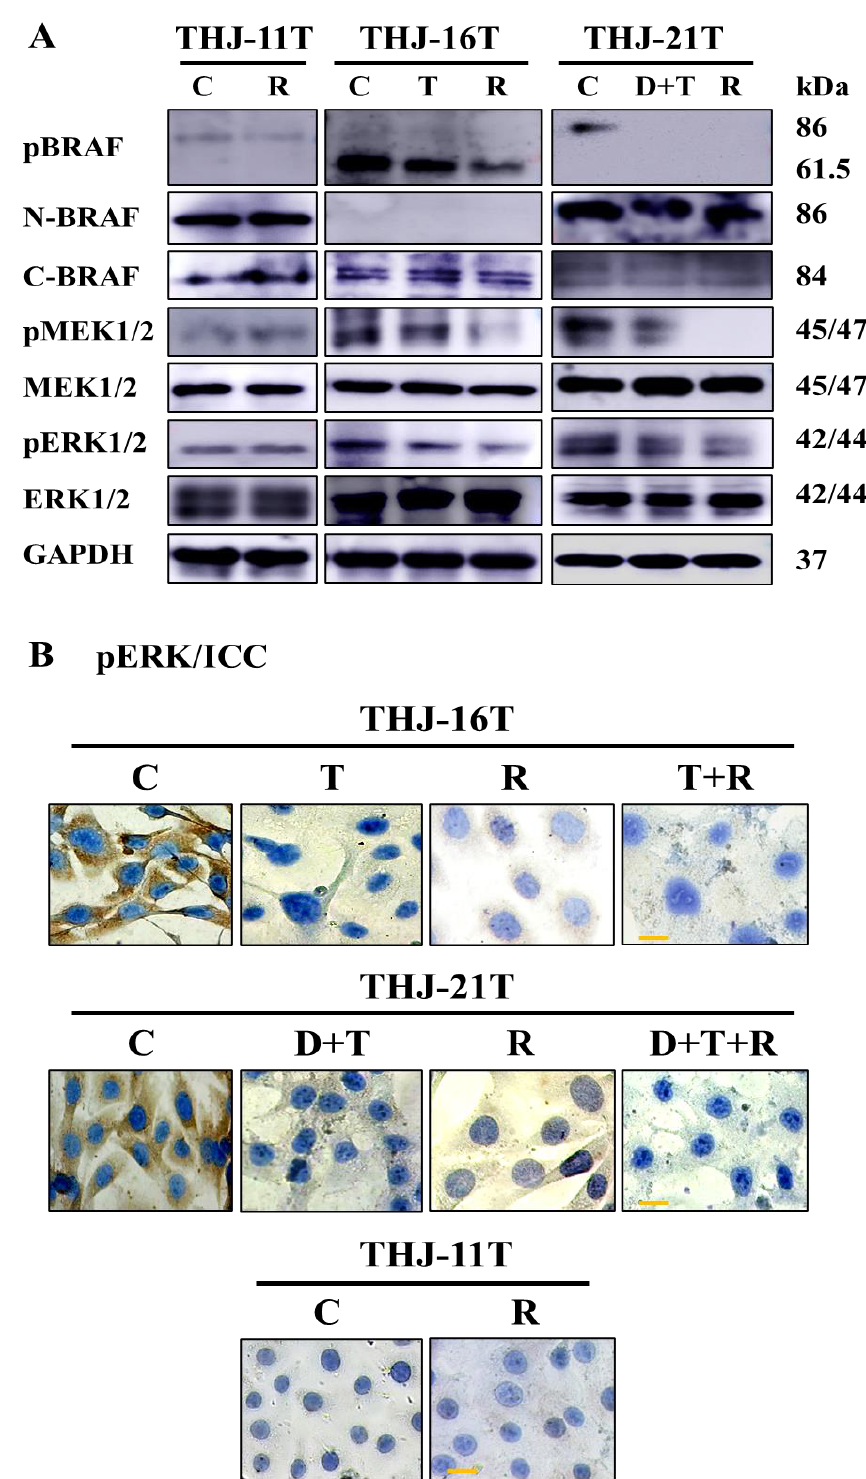
Figure 5. Differential pBRAF, BRAF, pMEK, MEK, pERK, ERK expression in THJ-11T, THJ-16T, and THJ-21T cells without and with resveratrol (R), trametinib (T), dabrafenib and trametinib (D+T), dabrafenib (D) and/or trametinib (T) in combination with resveratrol (R) treatment. ( A ) Western blotting was performed on the sample proteins of THJ-11T, THJ-16T, and THJ-21T cells before and after 48h drug treatment, GAPDH served as a loading control. ( B ) pERK immunocytochemical staining (scale bar, 5 µ m) performed on THJ-11T, THJ-16T, and THJ-21T cells after 48h drugs